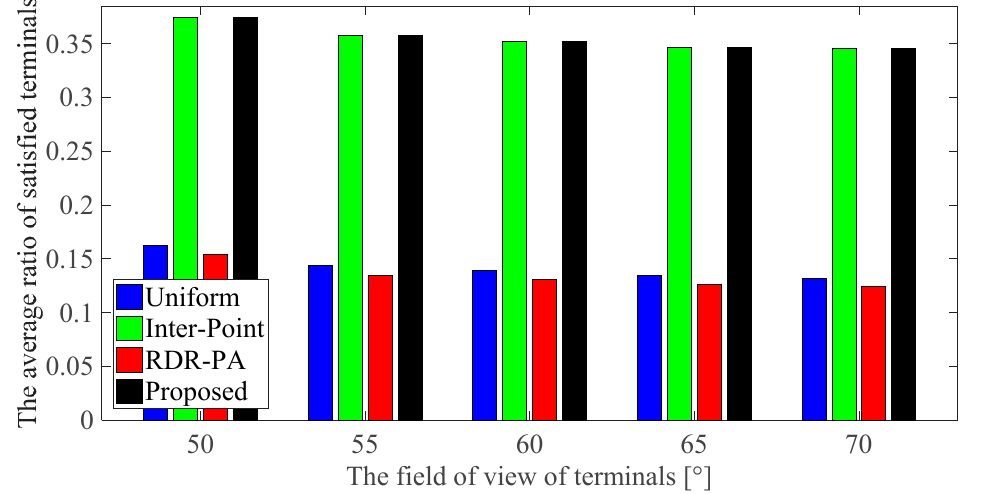
Figure 12. The average ratio of satisfied terminals versus the field of view.